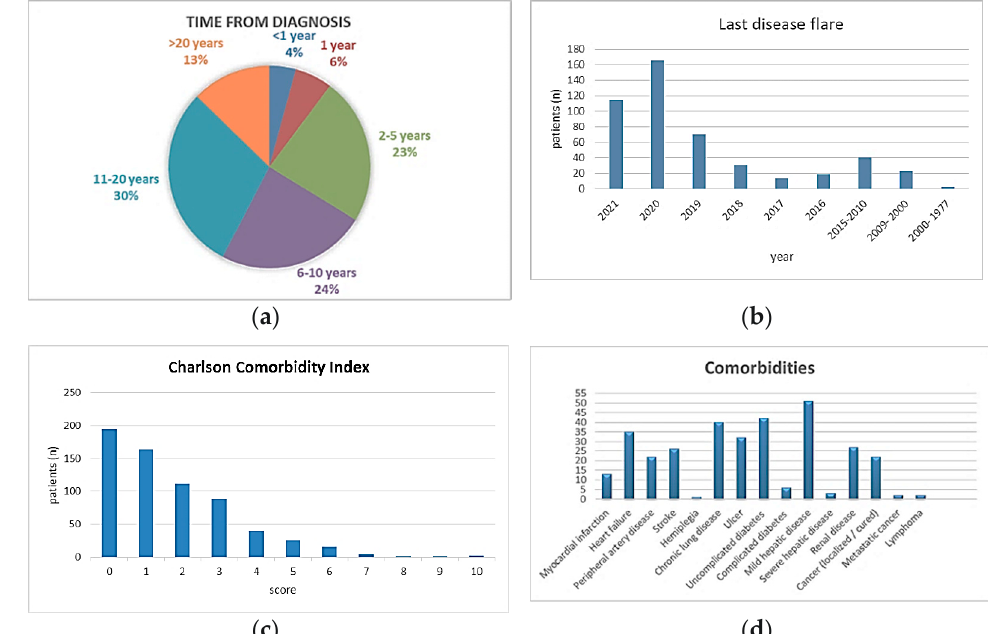
Figure 2. ( a ) Diagnosis of immune disease; ( b ) year of the last flare; ( c ) Charlson comorbidity index; ( d ) comorbidities reported .